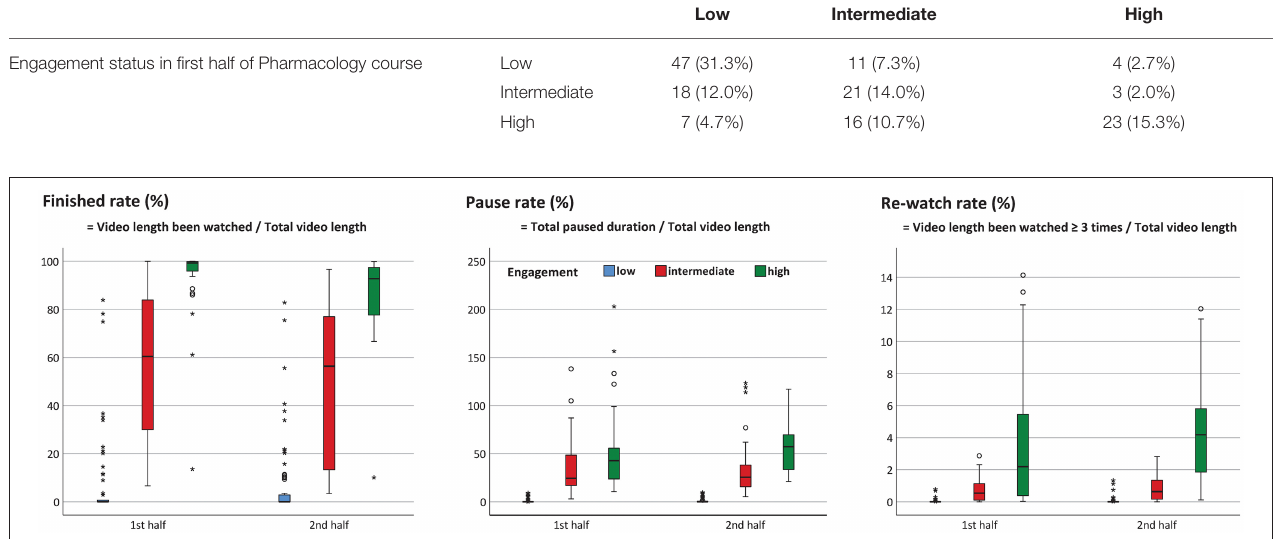
FIGURE 2 | The differences in the finished rate, the pause rate, and the re-watch rate among the students with different engagement levels ( p < 0.001 for all). *represents extreme value; ◦ represents potential